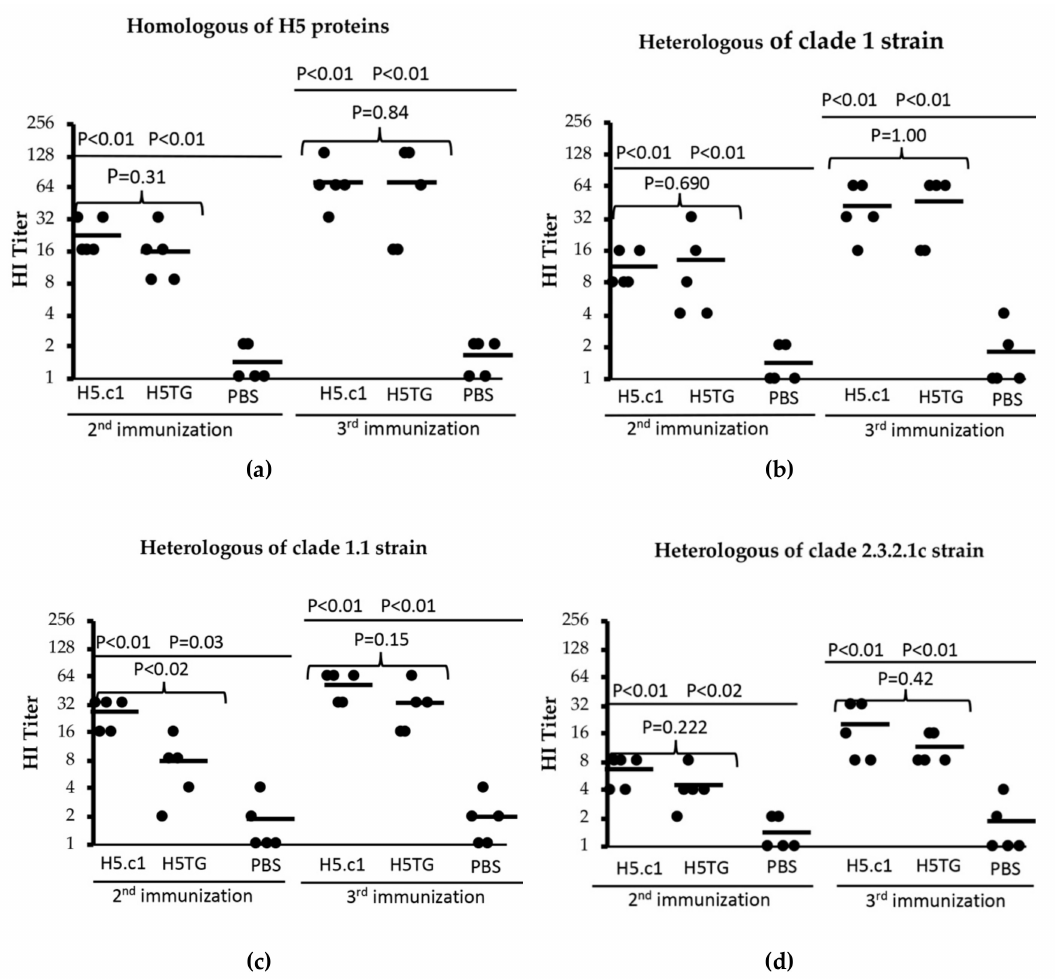
Figure 7. Haemagglutinin inhibition (HI) titres against homologous HA proteins ( a ) and heterologous strains (A / Vietnam / 1194 / 2004(H5N1) – clade 1 ( b ), A / duck / Vietnam / ST0970 / 2009(H5N1) - clade 1.1 ( c ) and A / duck / Vietnam / HT2 / 2014(H5N1) - clade 2.3.2.1c ( d